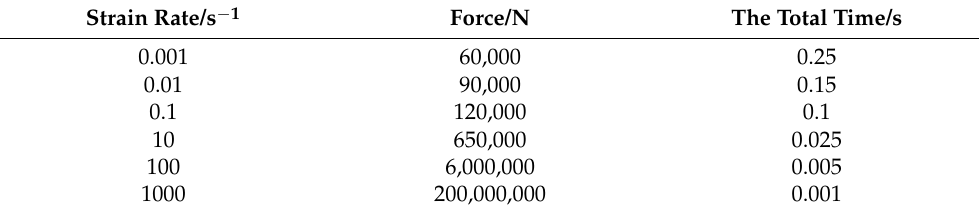
Table 1. The parameters of tensile fracture damage FEM for AlFeSi phase at 20 ◦